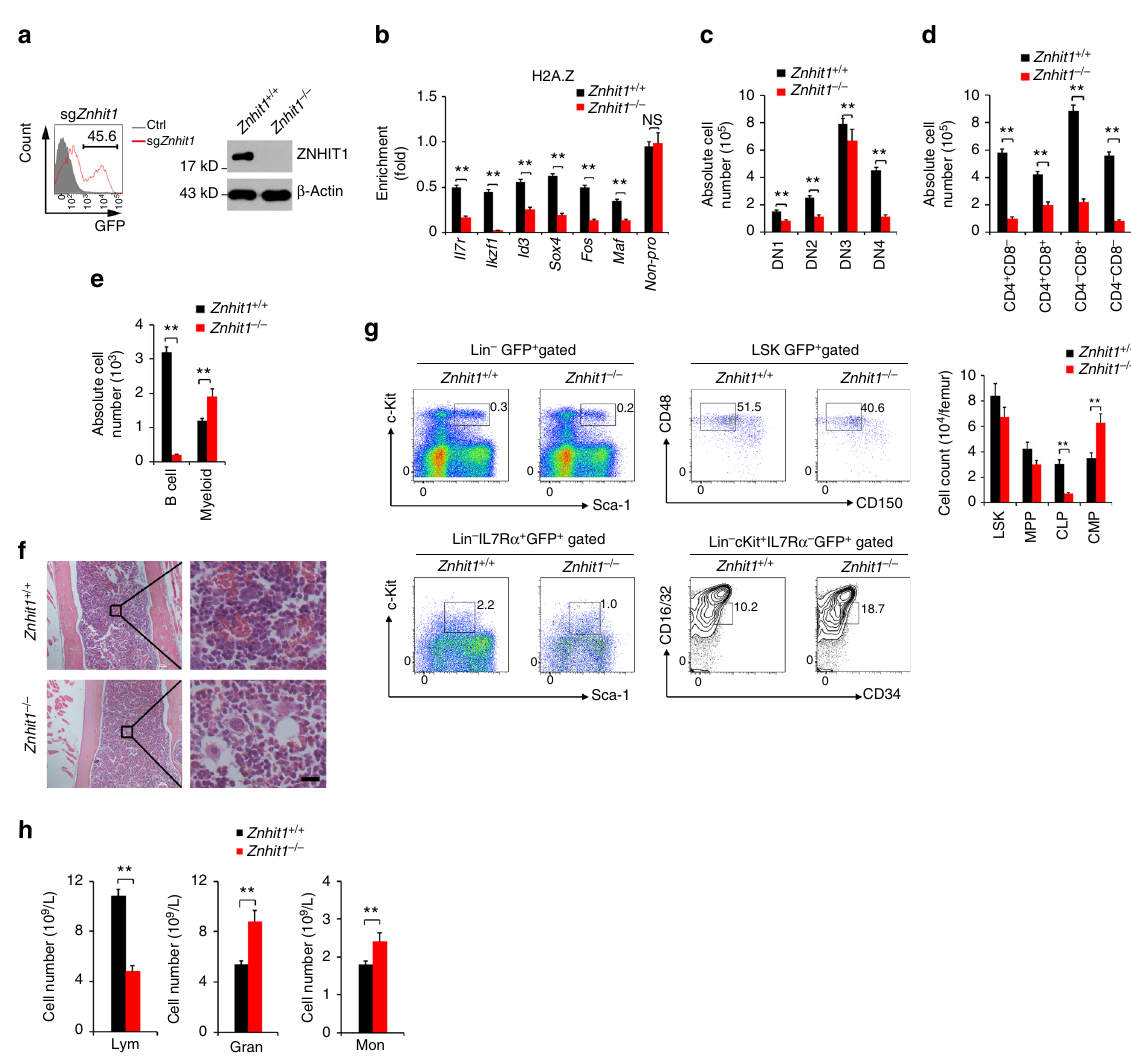
Fig. 6 Znhit1 deletion abrogates H2A/H2A.Z exchange to disrupt skewed lymphoid lineage commitment. a B6;129- Gt(ROSA)26Sor tm1(CAG-cas9*, − EGFP)Fezh /J knockin mice were crossed with Vav-Cre mice to obtain tissue-speci fi c Cas9 expression. HSCs were sorted and infected with sg Znhit1 -containing lentivirus and then transplanted into lethally irradiated recipient mice (CD45.1) for 8 weeks. ZNHIT1 was detected by immunoblotting. β -Actin were used as a loading control. b Indicated MPPs were sorted and lysed for ChIP assays with anti-H2A.Z antibody. Indicated promoters were examined by real-time qPCR. Signals were normalized to input DNA. c Indicated LMPPs were sorted and co-cultured with OP9-DL1 stromal cells as in Fig. 2c. Data are representative of six independent transfection and transplantation mice for each group. ** P < 0.01. d Cells were sorted, infected and cultured as in c and used Flt3 ligand alone thereafter. After 4 days, cells were harvested and analysed by fl ow cytometry. n = 6 for each group. ** P < 0.01. e Indicated MPPs were sorted and co- cultured with OP9 stromal cells as in Fig. 2c. Data are representative of six independent transfection and transplantation mice for each group. ** P < 0.01. f Paraf fi n sections from the femurs of Znhit1 -de fi cient mice were stained with H&E. Scale bars, 20 μ m. g Flow cytometric analysis of LSKs, MPPs, CLPs and CMPs from the BM of the indicated mice. ( n = 5); ** P < 0.01. h Peripheral blood cell numbers were analysed from the indicated transplanted recipient mice. Lymphocytes (Lym), monocytes (Mon), and granulocytes (Gran) were analysed. Results are shown as means ± S.D. Data are representative of six independent transfection and transplantation mice for each group. ** P < 0.01. Student ’ s t -test was used as statistical (Fig. 6h). Therefore, Znhit1 de fi ciency results in an opposite phenotype vs. Pcid2 KO mice. Collectively, Znhit1 deletion myeloid cells in periphery, respectively. However, how MPPs abrogates H2A/H2A.Z exchange in MPPs to disrupt lymphoid switch into CLPs or CMPs has not been de fi ned yet. In this study, lineage commitment capacity. we show that Pcid2 is highly expressed in the BM and MPPs. Pcid2 deletion in the haematopoietic system causes skewed lym- phoid lineage speci fi cation. Pcid2 -de fi cient HSCs prefer to dif- ferentiate into lymphoid cells but not into myeloid cells. In MPPs, PCID2 interacts with ZNHIT1 to block the SRCAP complex activity and prevents the H2A/H2A.Z exchange at nucleosomes of key lymphoid fate regulator genes. Pcid2 acts as one of the upstream inhibitors of PU.1 to impede the expression of key lymphoid fate regulator genes. Finally, Znhit1 deletion abrogates